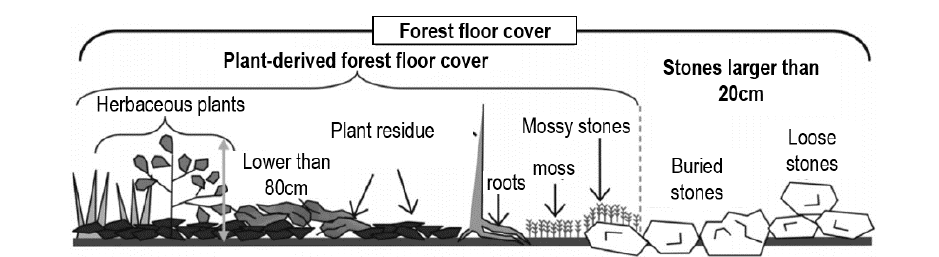
Figure 1. Criteria assessed in inspection of forest floor cover in National Forest Inventory of Japan, adapted from the NFI manual